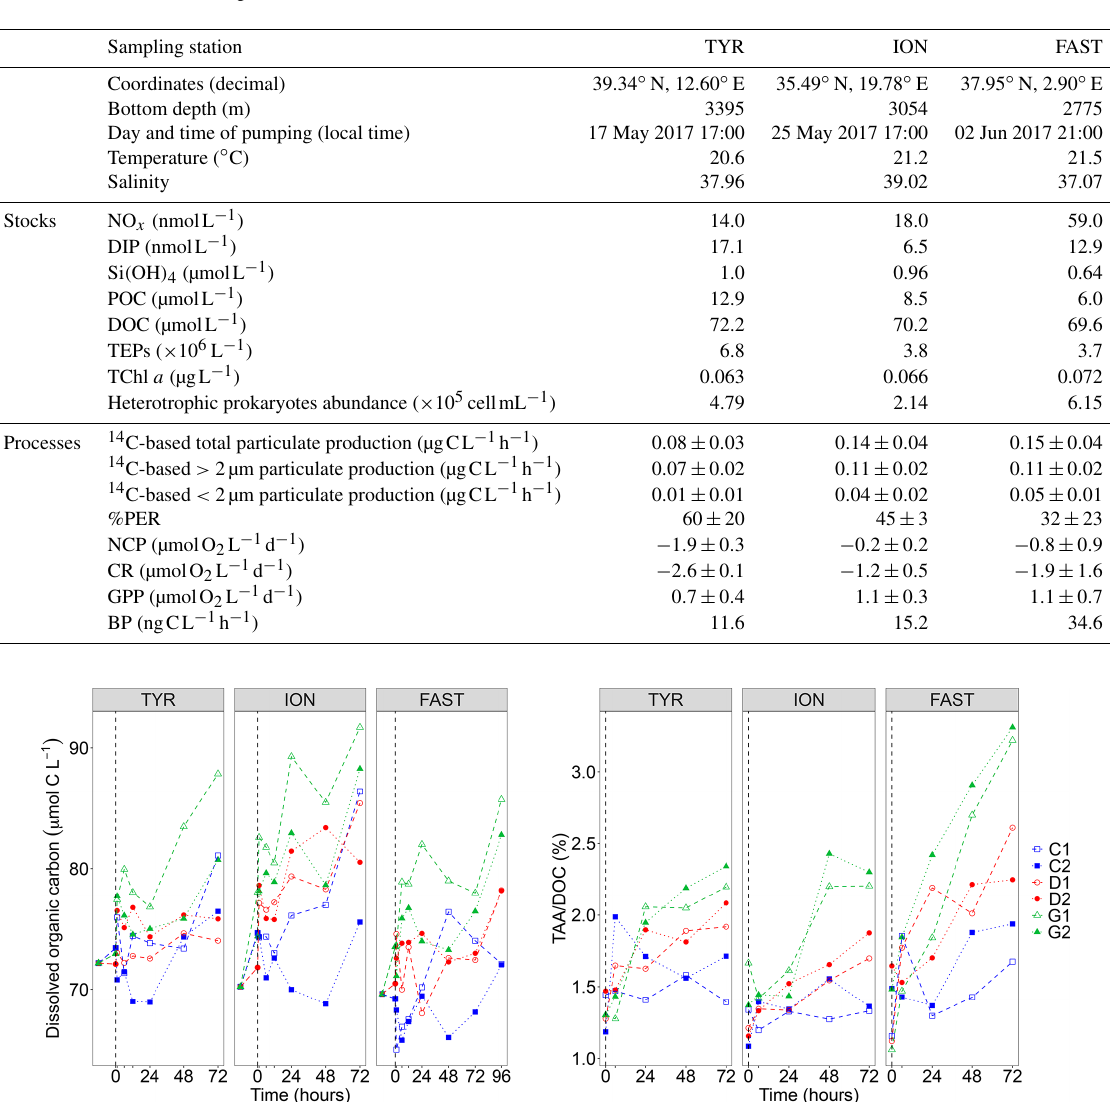
Table 1. Initial chemical and biological stocks as measured while filling the tanks (initial conditions in pumped surface water; sampling time: t − 12h). NO x : nitrate and nitrite, DIP: dissolved inorganic phosphorus, Si ( OH ) 4 : silicate, POC: particulate organic carbon, DOC: dissolved organic carbon, TEPs: transparent exopolymer particles, TChl a : total chlorophyll a . Values shown for 14 C incorporation rates and percentages of extracellular release (%PER) as well as for net community production (NCP), community respiration (CR) and gross primary production (GPP) were estimated from samples taken at t 0 in the control tanks. For heterotrophic bacterial production (BP), rates were estimated from seawater sampled at t − 12h.